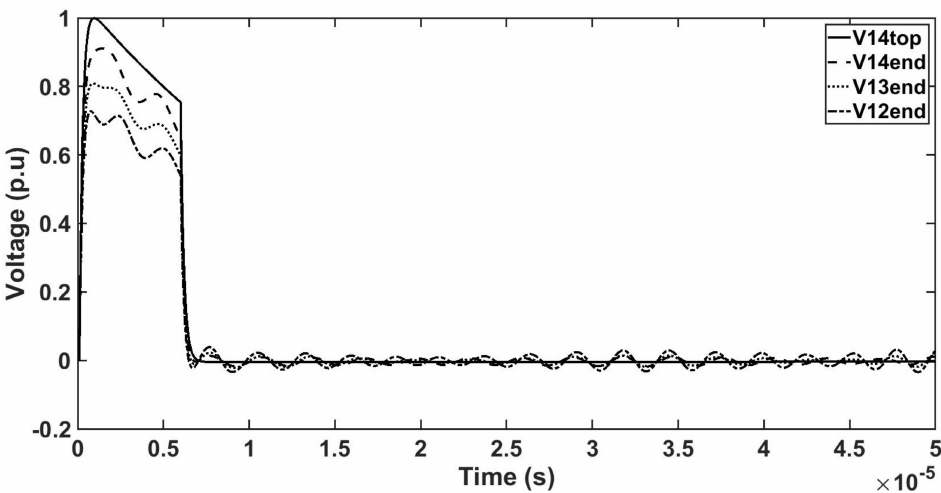
Figure 24. Surge voltage waveforms in a winding with shield between HV and LV winding due to